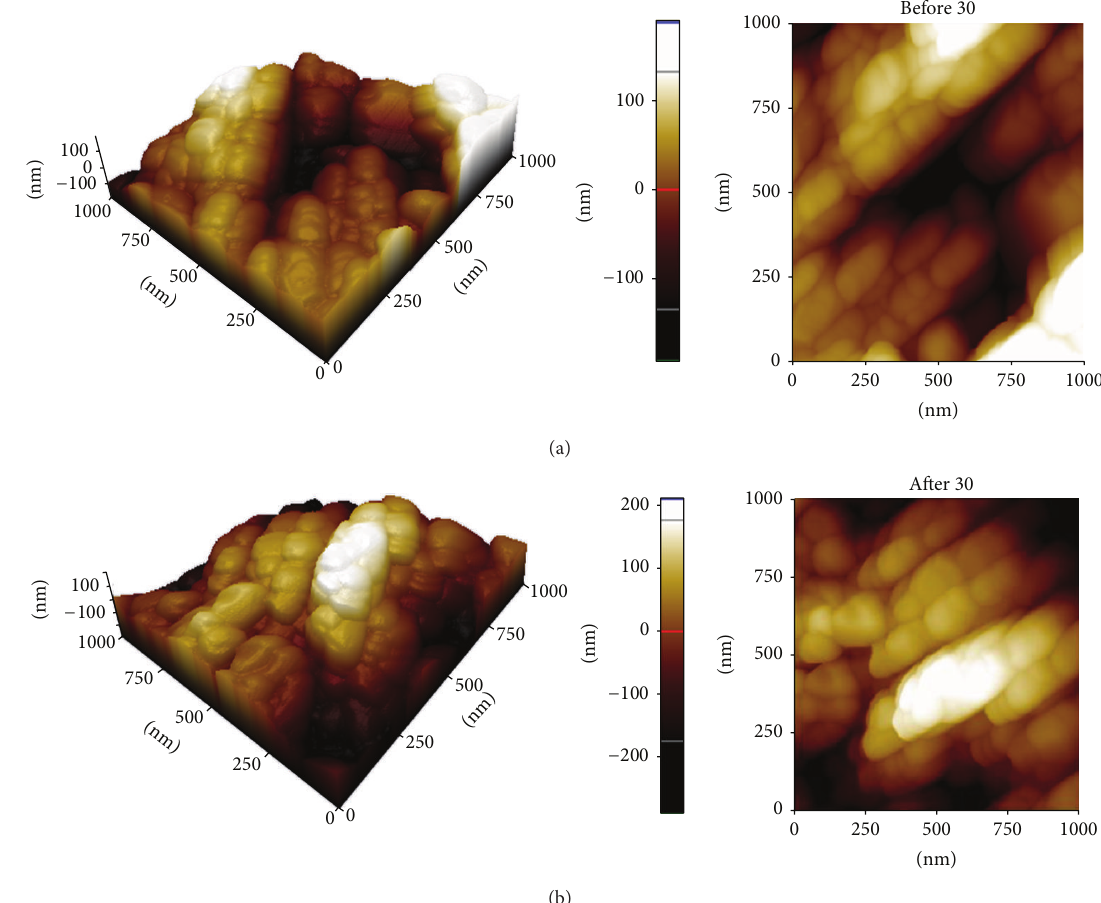
Figure 6: (a) 3D surface structure of untreated TiO 2 film in range of 25 𝜇 m 2 along with histogram. (b) 3D surface structure of treated TiO 2 film in range of 25 𝜇 m 2 along with histogram.